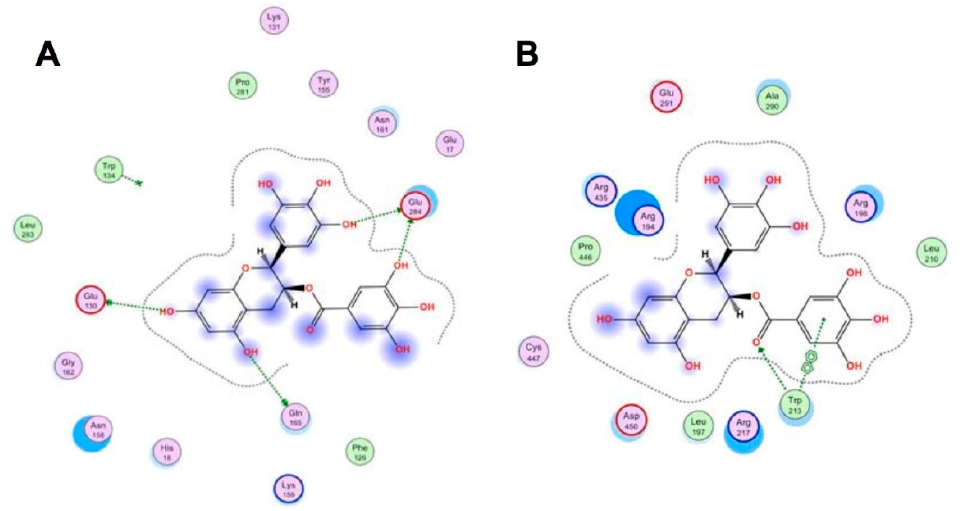
Figure 2. CMDA of EGCG binding to bovine SA. Interaction of EGCG with Trp134 ( A ) and Trp213 ( B ) are shown. Green broken arrows represent hydrogen bonding. The gallate group forms a hydrophobic bond with Trp213 ( B ). Cited from [12] under the terms of the Creative Commons Attribution-NonCommercial-ShareAlike License.